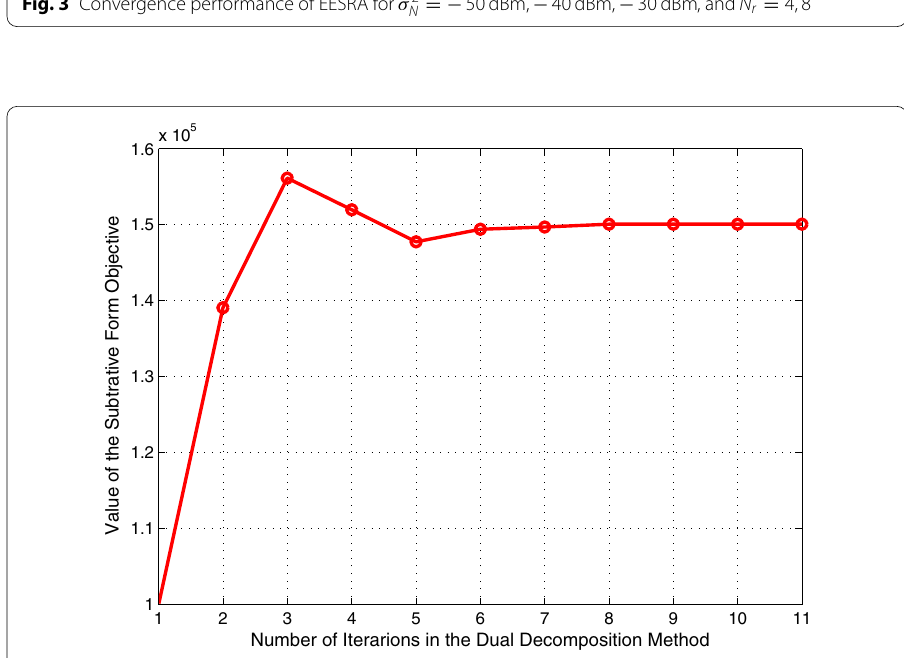
Fig. 4 Convergence of the dual decomposition method with q = 2.82